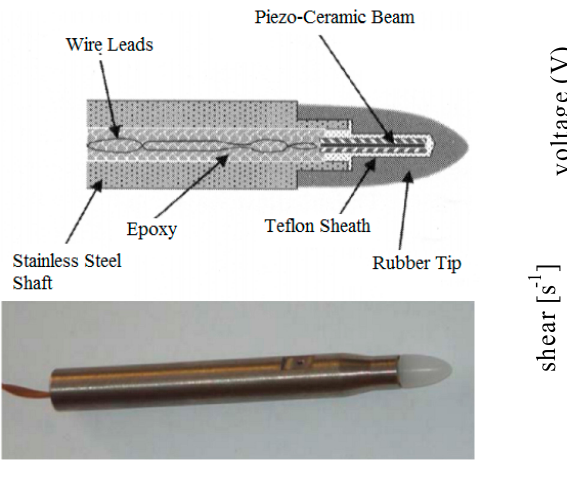
Figure 2. The sensors and the collected ocean turbulence shear signals. ( a ) The structure of the shear probes; ( b ) the original ocean turbulence shear signals.